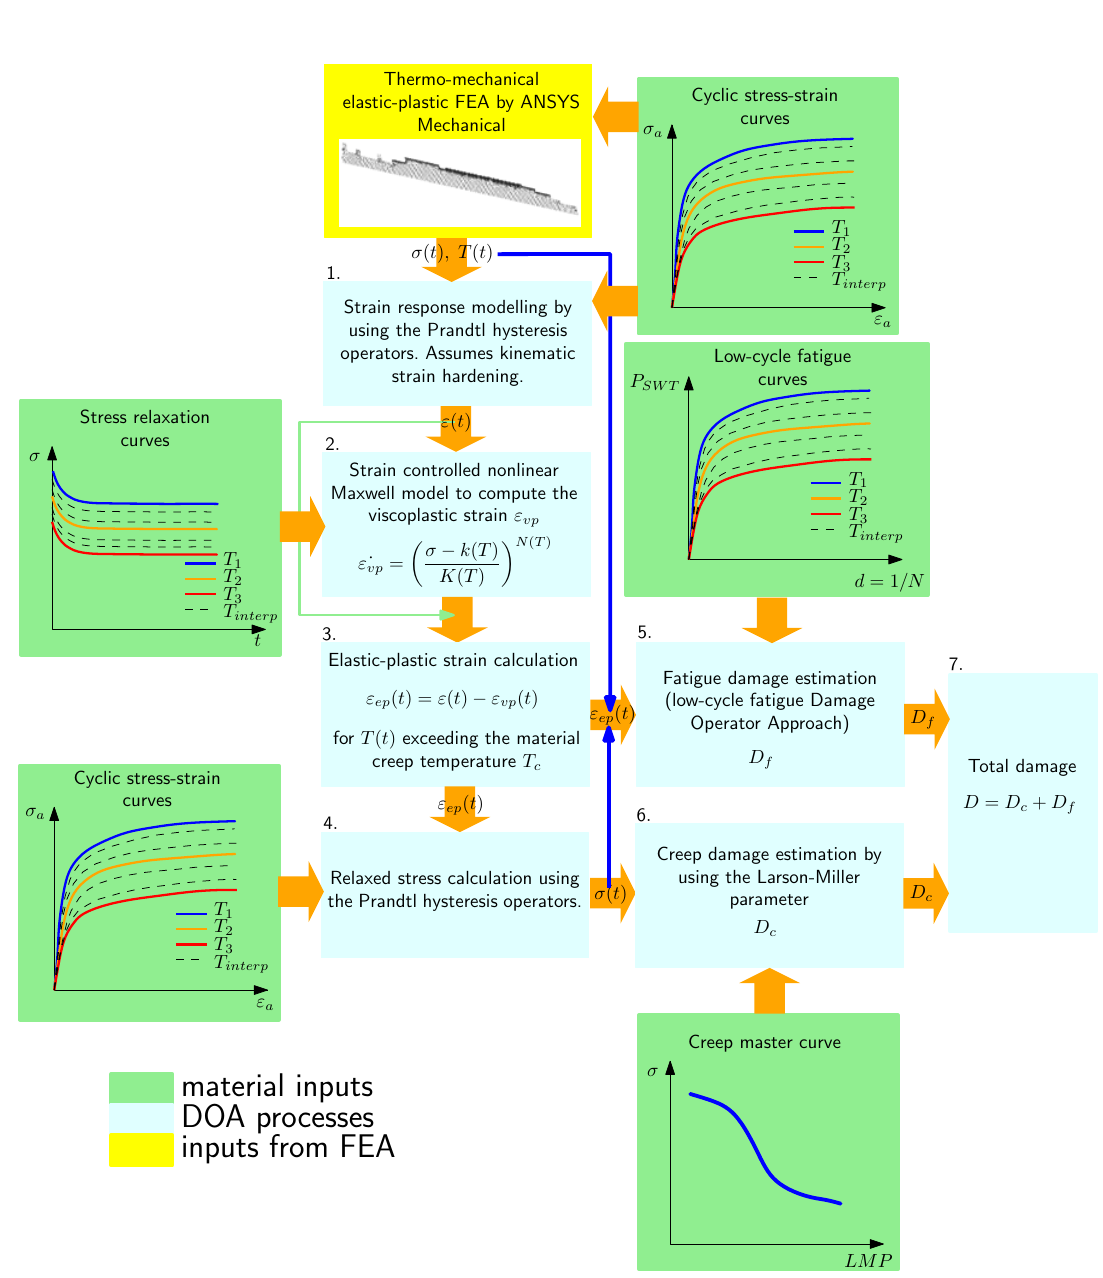
Figure 11. Flowchart to illustrate the basics of the Damage Operator Approach by Nagode et al.